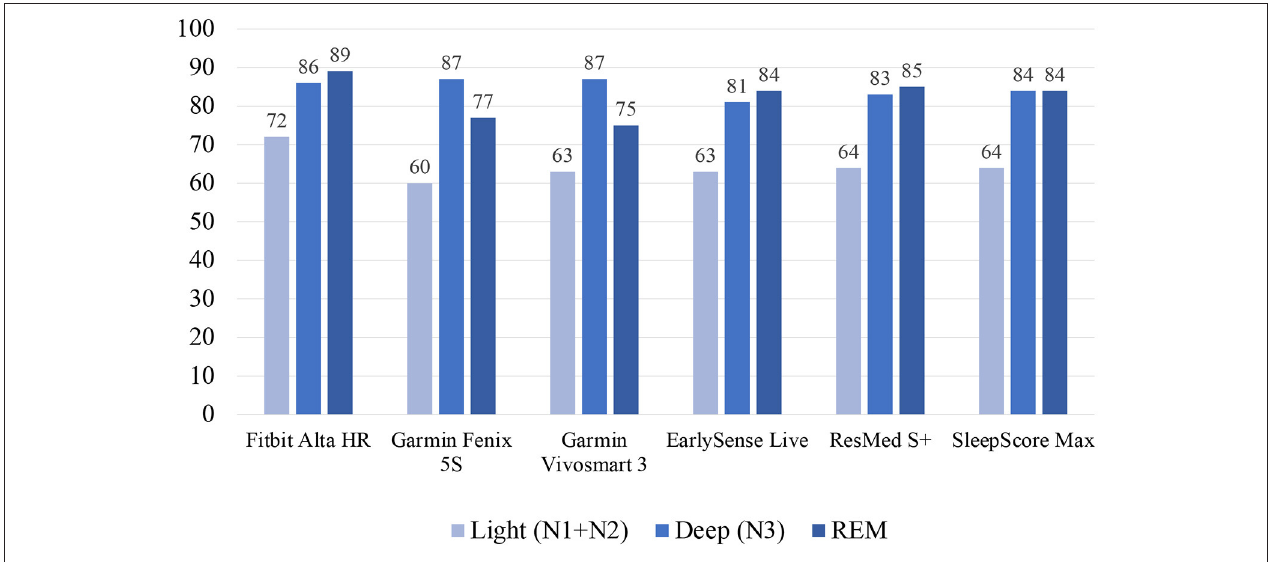
FIGURE 7 | Sleep staging validation for wearables and non-wearables from Chinoy et al.